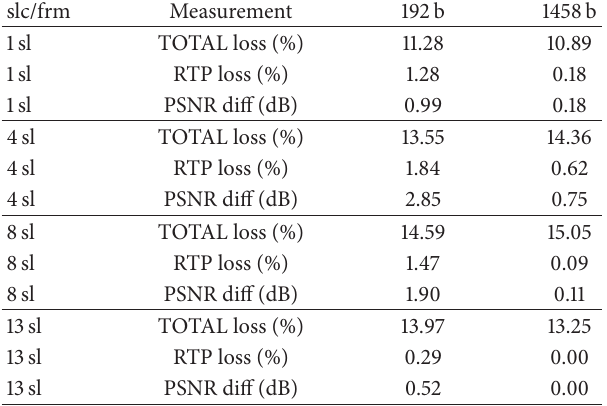
Table 4: Total percentage of network packet loss, percentage of RTP packet loss after recovery, and difference in PSNR of the reconstructedvideo,forabackgroundtrafficof390 ppsandalevelof protection of 30%, for areas with good signal coverage. LP encoding